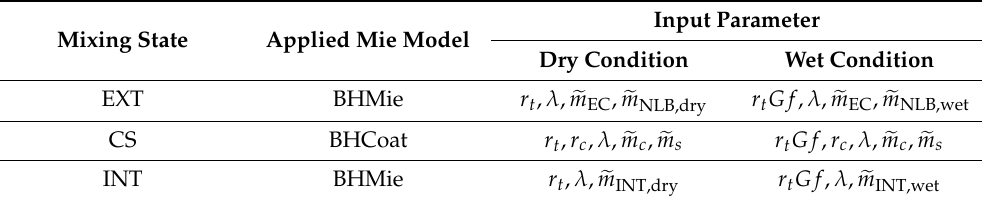
Table 1. Input parameters and the applied Mie model for the three mixing states under dry and wet